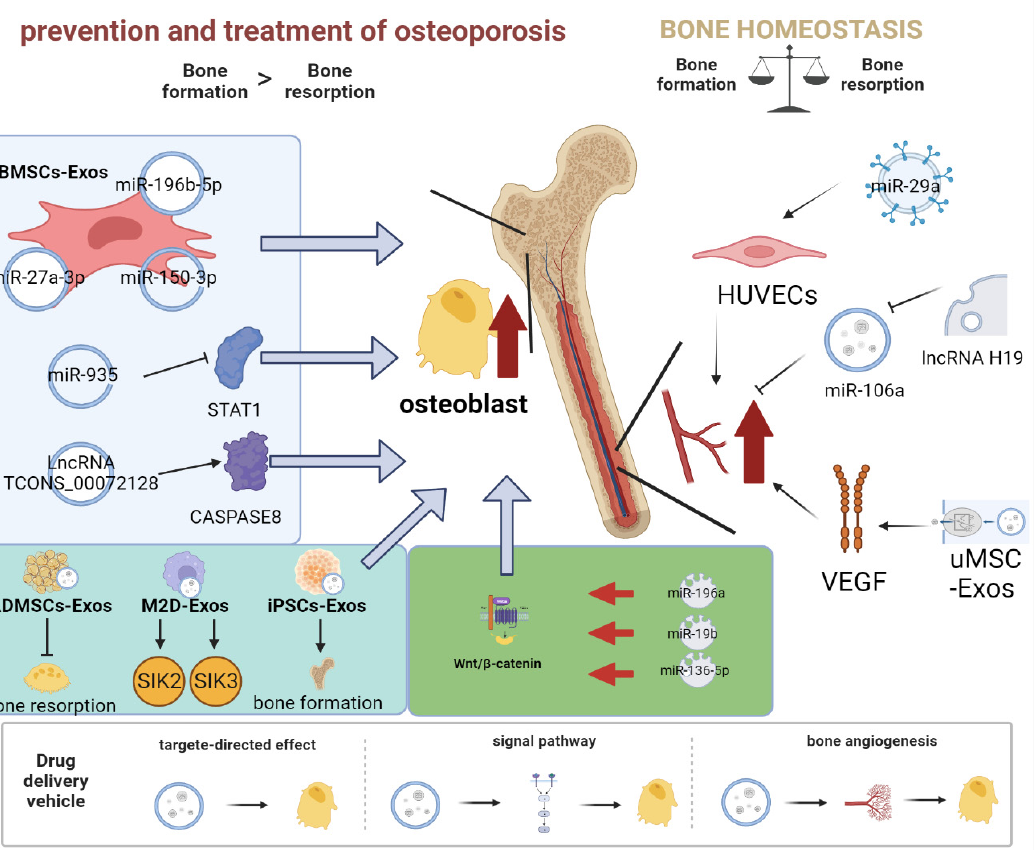
Figure 3. Exosomes act as drug delivery systems in osteoporosis. Exosomes can carry bioactive molecules that act directly on osteoblasts and promote osteoblast proliferation through signaling pathways, while bone angiogenesis also provides a way to prevent osteoporosis.